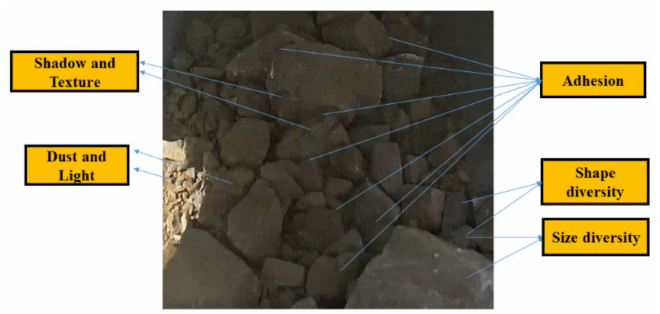
Figure 1. An example of ore